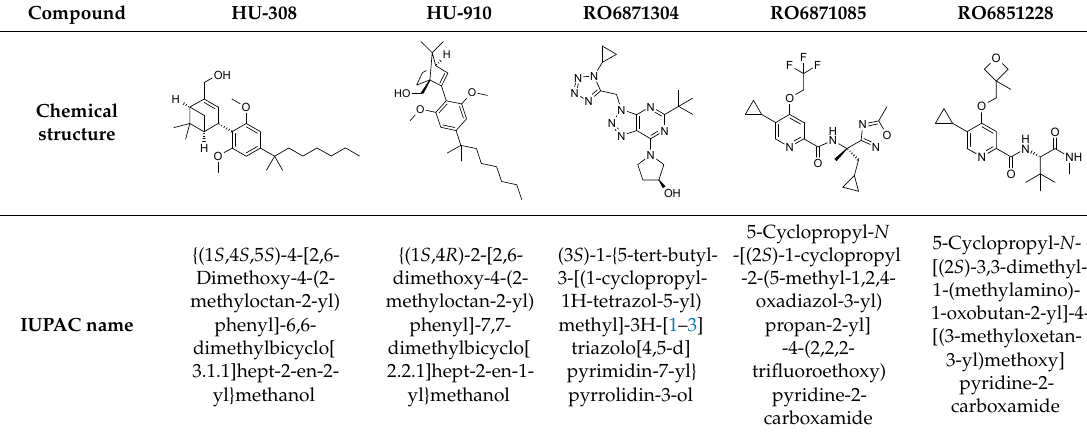
Table 1. Chemical structures and International Union of Pure and Applied Chemistry (IUPAC) names of cannabinoid 2 receptor (CB 2 R) ligands used in EIU model.